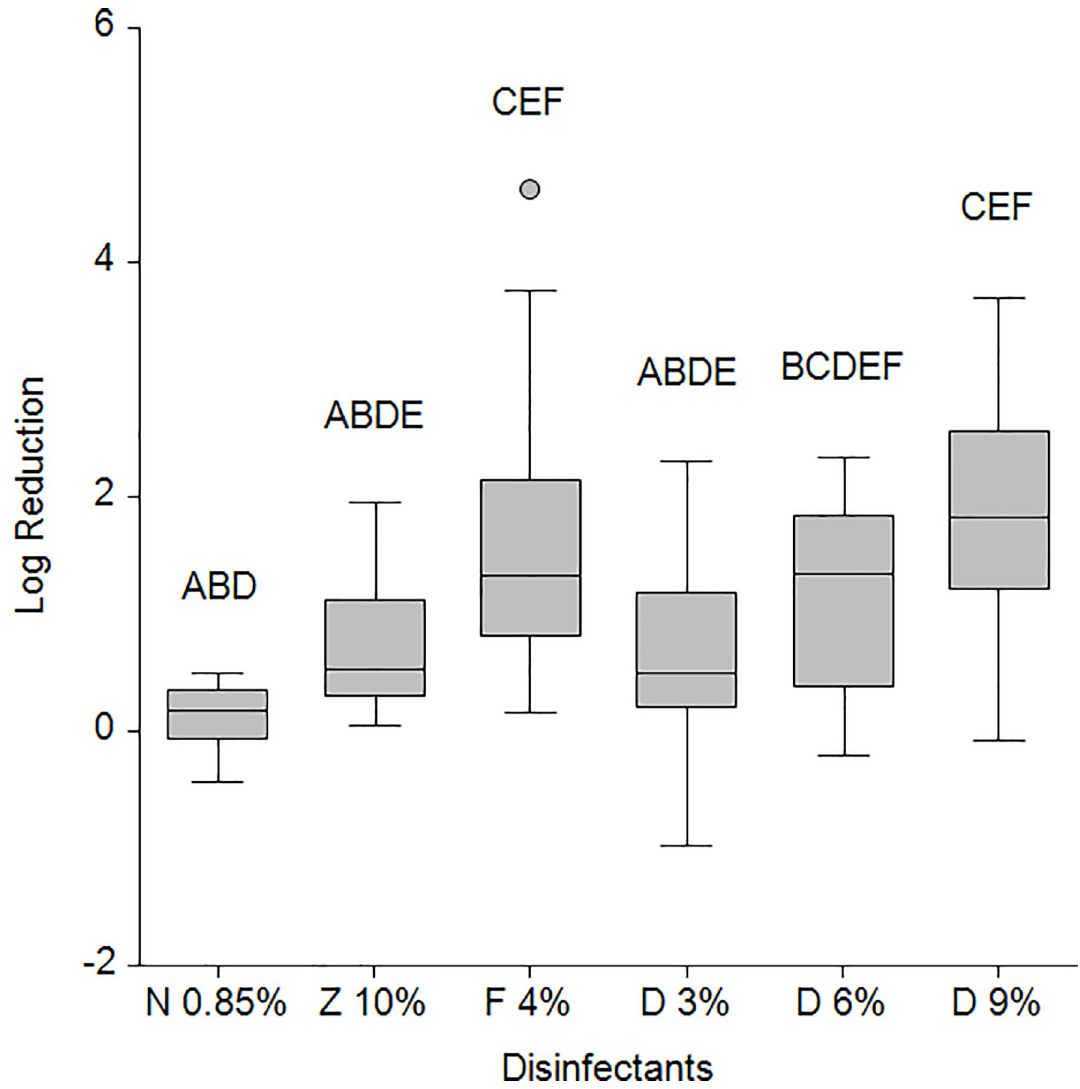
Fig 3. Efficiency of disinfectants in ex vivo experiments. Log-fold reduction of tested disinfectants against virulent D . nodosus determined by PMA-qPCR in the ex vivo experiments. Different superscript letters indicate significant differences in the mean at z- value > 1.9600. N 0.85% (NaCl 0.85%), Z 10% (10% Zinc sulfate), F 4% (4% Formaldehyde), D 3% (3% Desintec), D 6% (6% Desintec), D 9% (9%